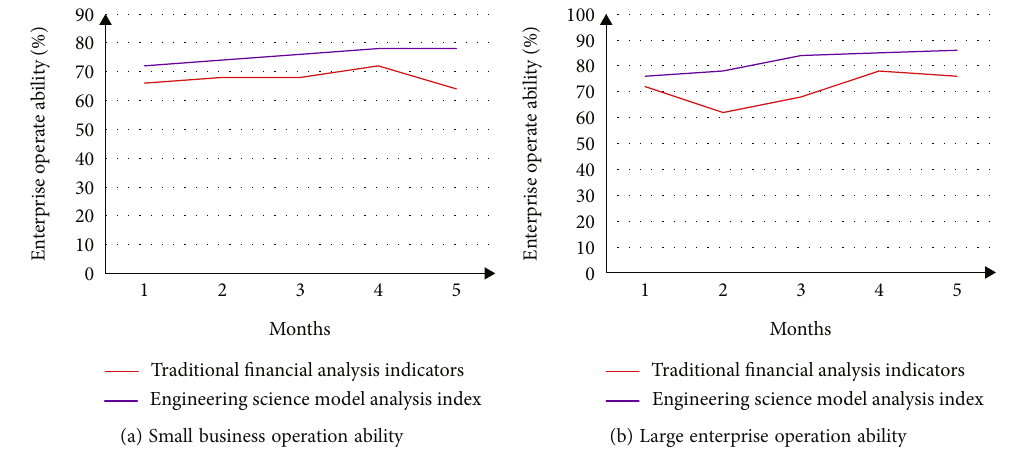
Figure 7: Comparison results of enterprise management